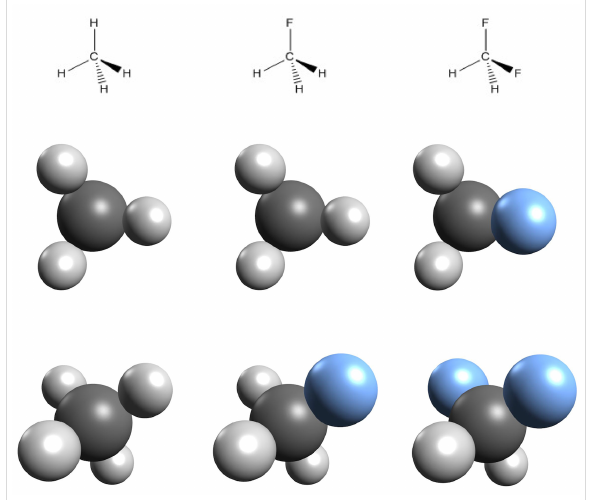
Figure 1: Methane, fluoromethane, and difluoromethane in Lewis representation (top, left to right), in ball and stick representation from a viewpoint covering one atom in each molecule (middle) and in ball and stick representation from a shifted viewpoint (bottom). Carbon = dark grey, hydrogen = light grey, fluorine =